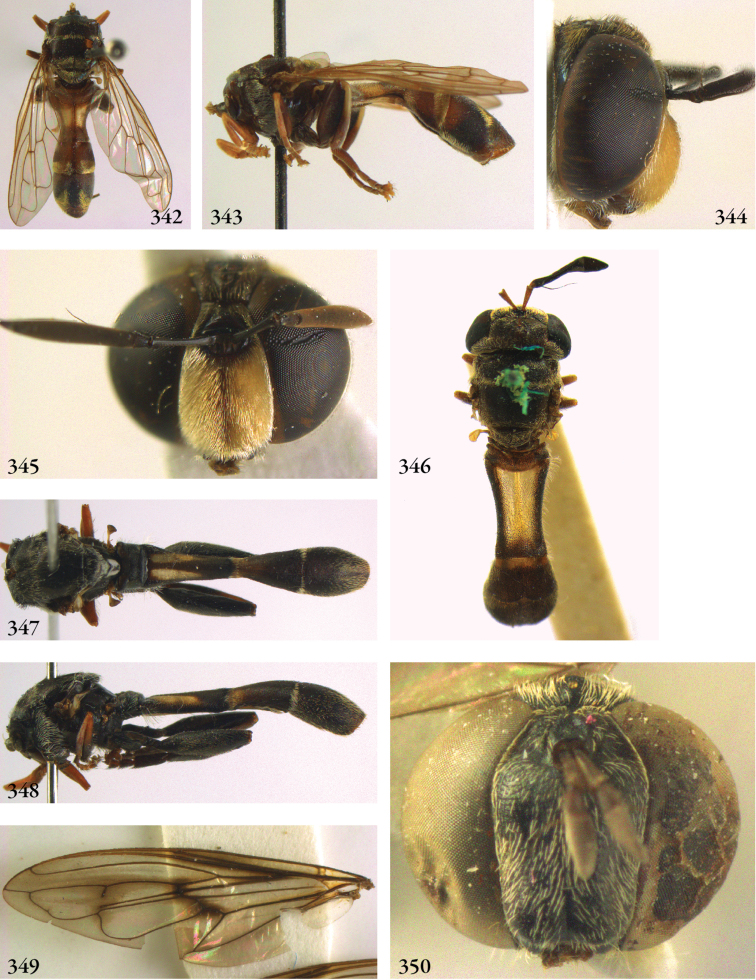
342–345
Rhopalosyrphus (s.l.) abnormoides male (holotype): 342 habitus dorsal 343 habitus lateral 344 head lateral 345 head frontal 346
Rhopalosyrphus (s.l.) cerioides male (holotype), habitus dorsal 347–350
Rhopalosyrphus (s.l.) oreokawensis male (holotype): 347 habitus dorsal 348 habitus lateral 349 wing 350 head frontal.